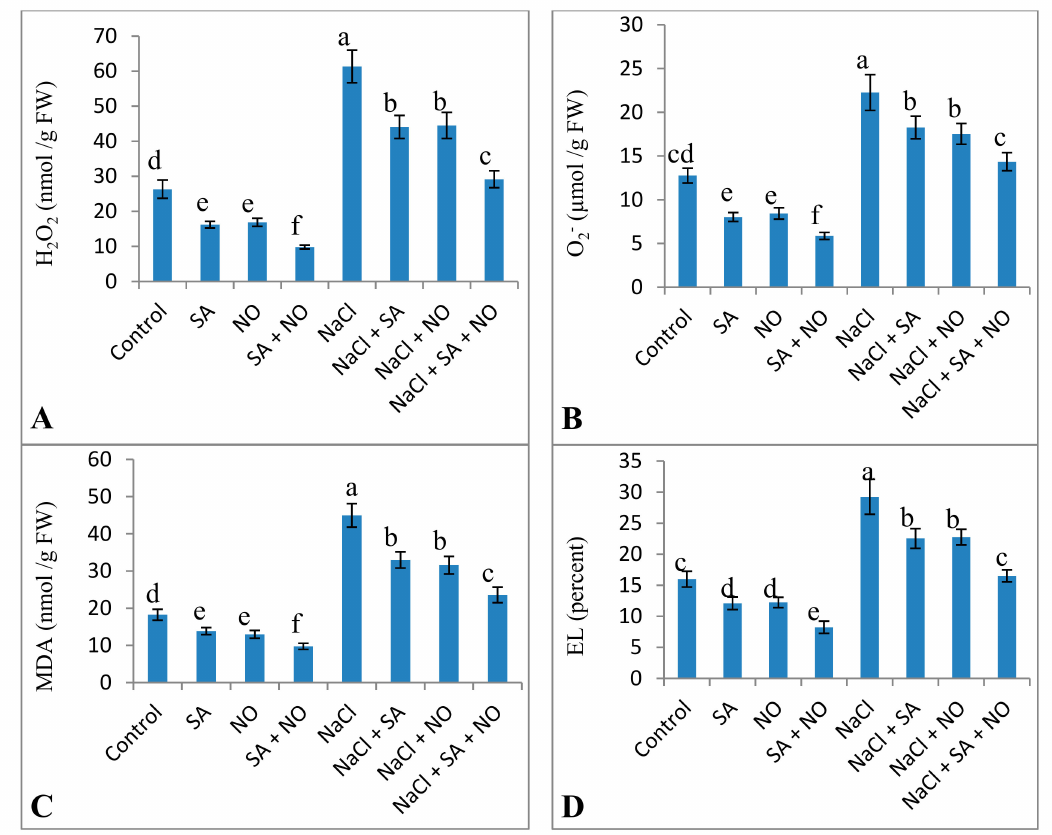
Figure 3. E ff ect of exogenous application of SA and NO on ( A ) hydrogen peroxide, ( B ) superoxide, ( C ) lipid peroxidation (MDA), and ( D ) electrolyte leakage (EL) in Vigna angularis under salinity (100 mM NaCl) stress. Data are the mean of four replicates and di ff erent letters show significant di ff erence at p < 0.05.